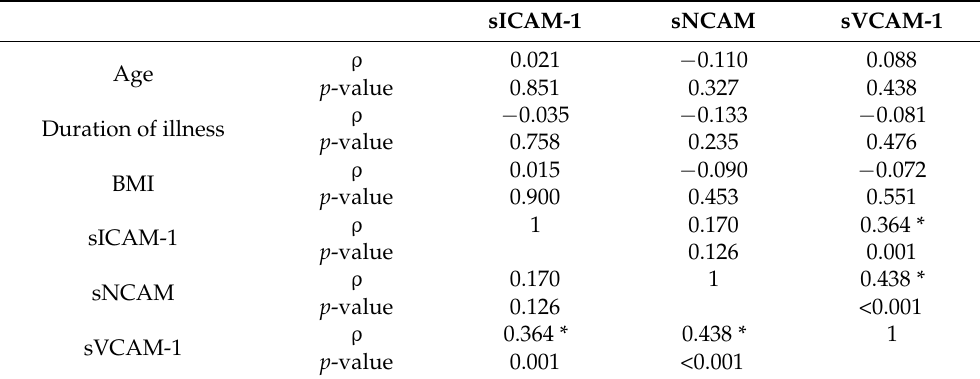
Table 5. Spearman’s analysis of correlation between CAMs, age, duration of schizophrenia, and the BMI among patients with MetS.